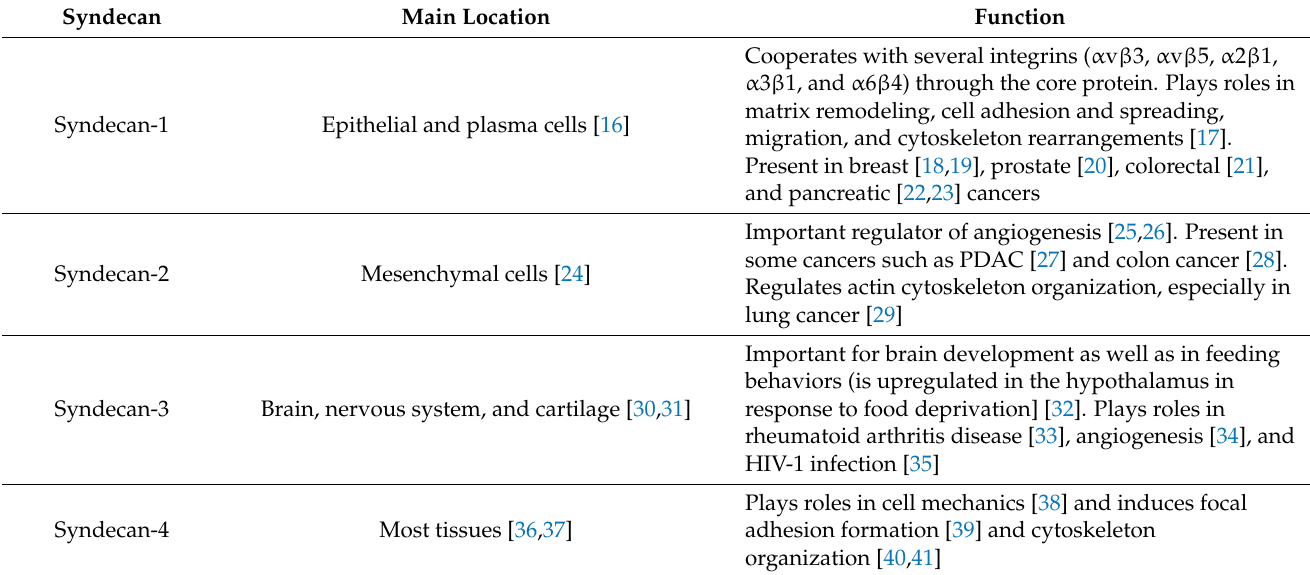
Table 1. Syndecans location and principal functions as transmembrane